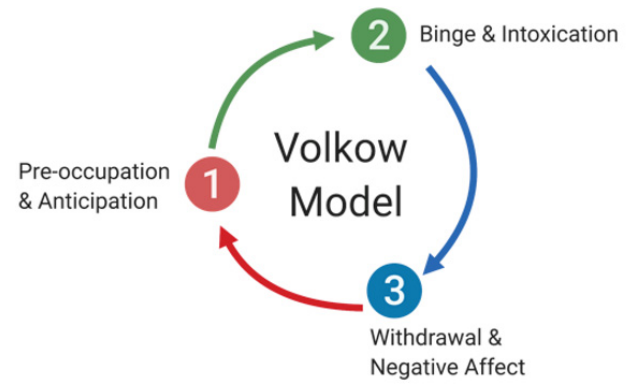
Figure 1. The cycle of addiction and its stages. Addiction can be divided into three major stages involving specific neurocircuits within the brain: ( 1 ) preoccupation and anticipation, which involve prefrontal cortex circuitry, ( 2 ) binge and intoxication, which is thought to primarily involve basal ganglia circuitry, and ( 3 ) withdrawal and negative affect, which are dependent on the amygdala. During the development of addiction, individuals move from impulsive to compulsive drug taking, which is accompanied by a shift from positive to negative reinforcement